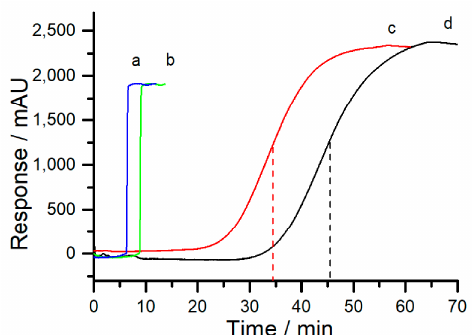
Figure 2. Breakthrough curves on different monoliths: ( a ) For thiourea (marker for void time) on poly (OMA-co-TRIM) monolith; ( b ) for thiourea (marker for void time) on poly (OMA-co-EDMA) monolith; ( c ) for 2,4-D on the poly (OMA-co-EDMA) monolith; ( d ) for 2,4-D on the poly (OMA-co-TRIM) monolith. Experimental conditions: The monolith, 20 cm × 250 μ m i.d.; mobile phase, 98% (v/v) 0.1% trifluoroacetic acid (TFA) solution and 2% ( v / v ) ACN; pump flow rate, 10 μ L/min; the concentraction of thiourea, 200 ng/mL; the concentraction of 2,4-D, 200 ng/mL; UV detection wave, 223 nm.